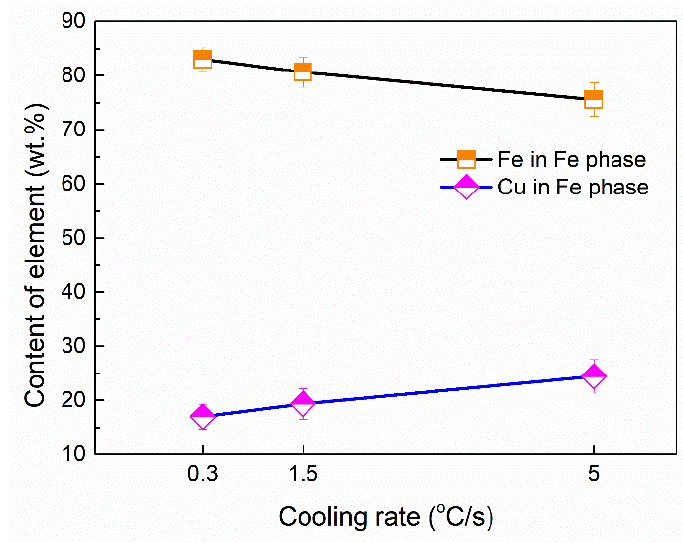
Figure 11. Average chemical composition in the Fe phase dendrite.